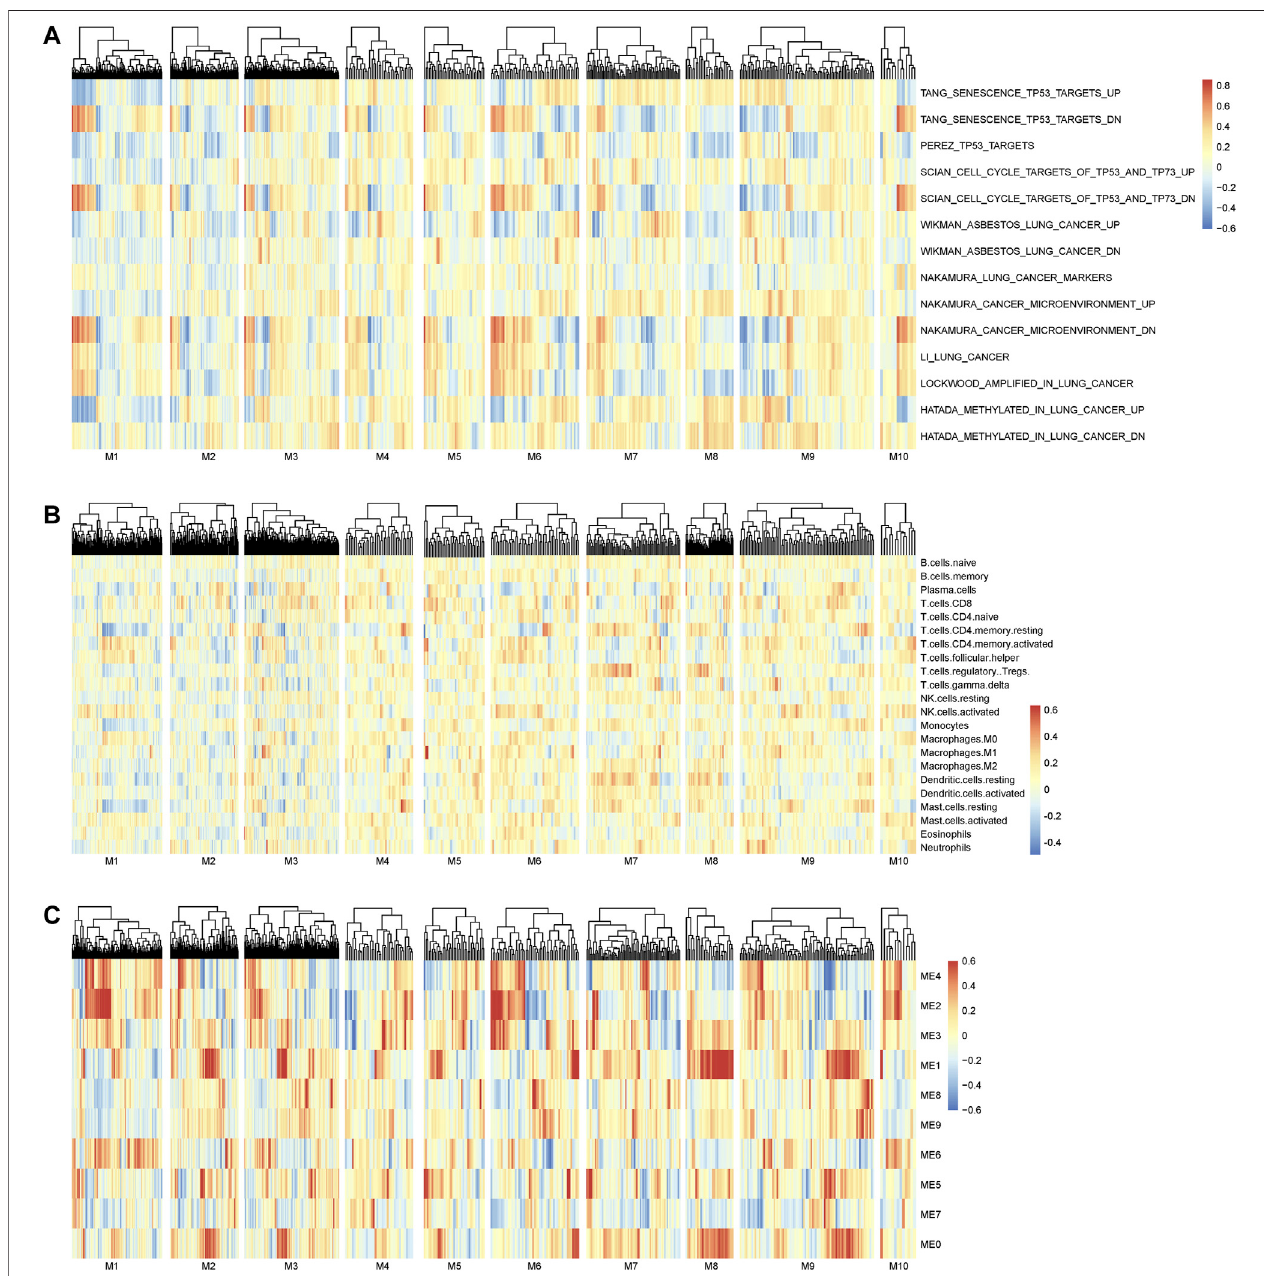
FIGURE 8 | Association analysis on the nQTL module and different factors. (A) The association between the nQTL module and (GSVA) pathway enrichment/ activity. (B) TheassociationbetweenthenQTLmoduleand(CIBERSORT)cellcomposition. (C) TheassociationbetweenthenQTLmoduleand(WGCNA)co-expression module. A few nQTL modules are associated with or driven by potential biological mechanisms, e.g., pathway function, cell composition, or gene co-expression. And many othernQTL modulesshouldbenewonesthataredetermined byparticulargenotypesthroughbiologicalnetworkrewiring, accordingtotheirGOenrichment and network